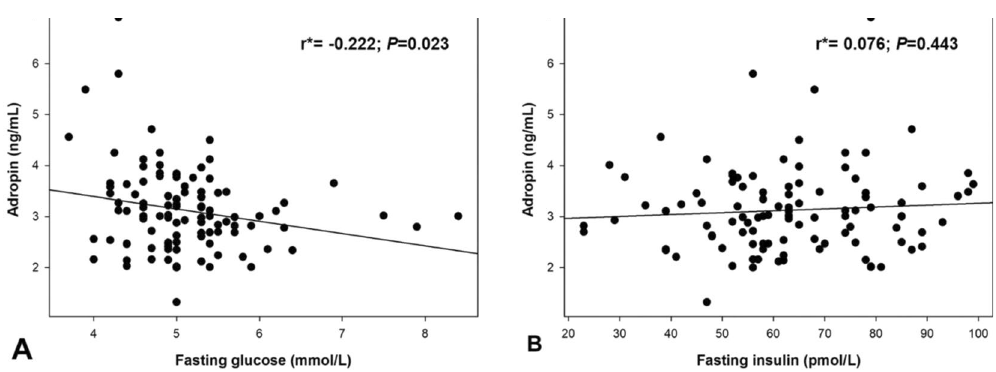
Figure 2. Correlation analysis of adropin levels with fasting glucose ( A ) and insulin levels ( B ) in total study population ( N = 105). * Pearson’s correlation